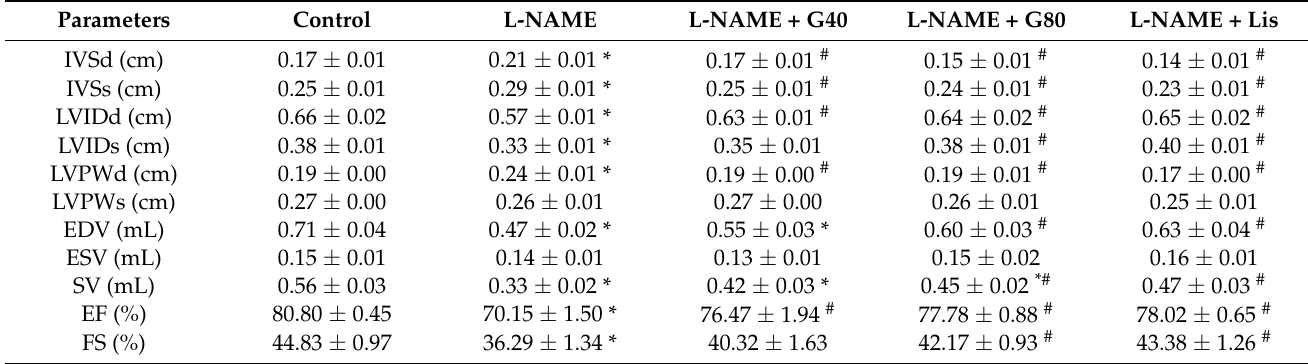
Table 3. Effect of genistein on cardiac function in L-NAME-induced hypertensive rats.